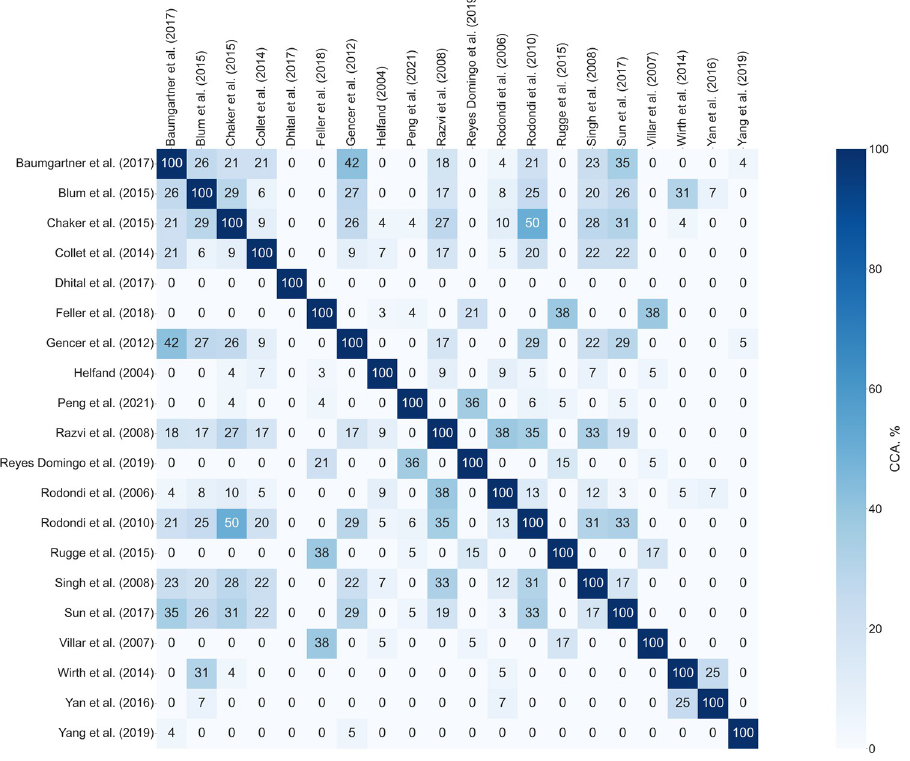
Fig 2. Heatmap showing pairwise calculated